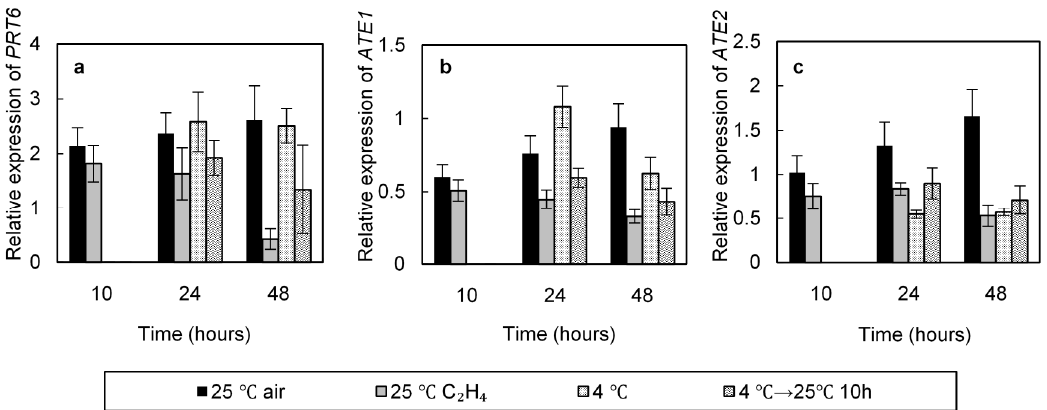
Figure 5. Relative expression of PRT6 ( a ), ATE1 ( b ), and ATE2 ( c ) in seeds (Col-0) incubated at 25 ◦ C or at 4 ◦ C on water, at 25 ◦ C for 10 h after stratification at 4 ◦ C, and at 25 ◦ C in the presence of ethylene 100 ppm. An arbitrary value of 1 was assigned to dry seeds. Means of three replicates ± SD. Seeds harvested in